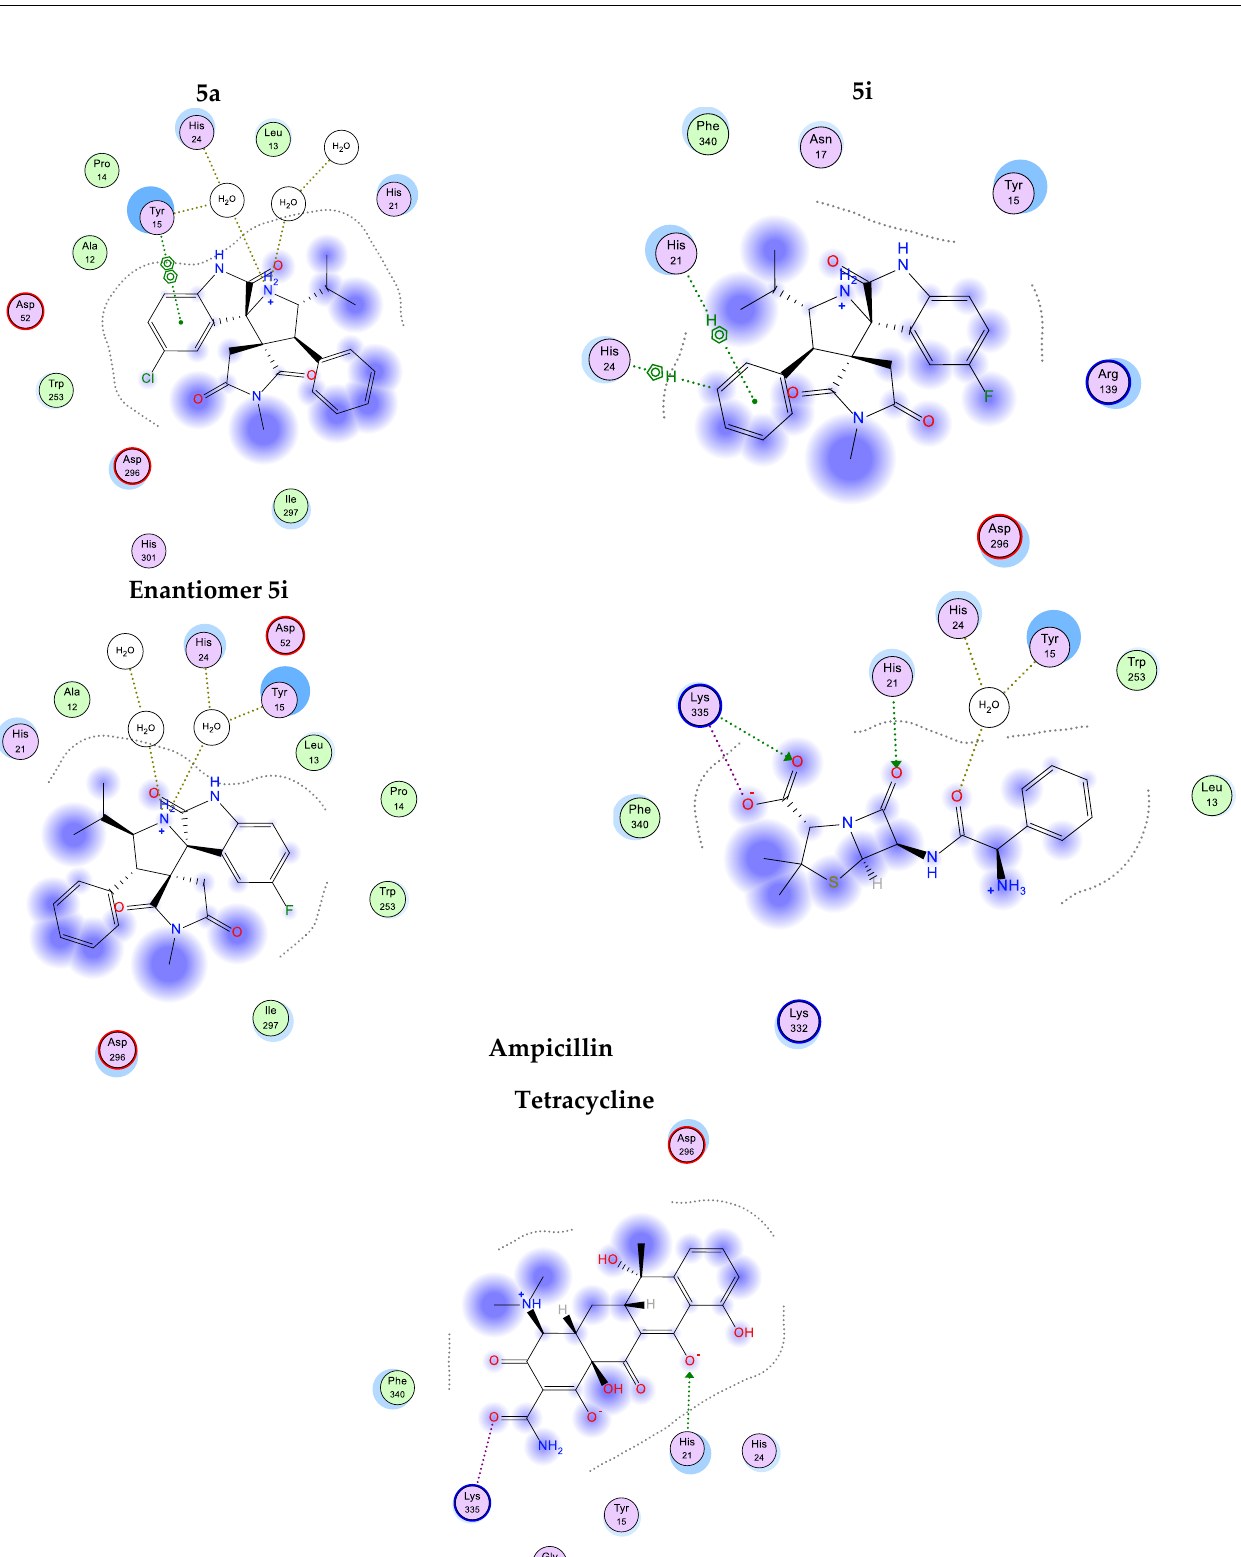
Figure 9. 2D-interactions of compounds 5a , 5i, 5i enantiomer , Ampicillin and Tetracycline with amino acid residues on methionyl-trnasynthetase (1PFV).